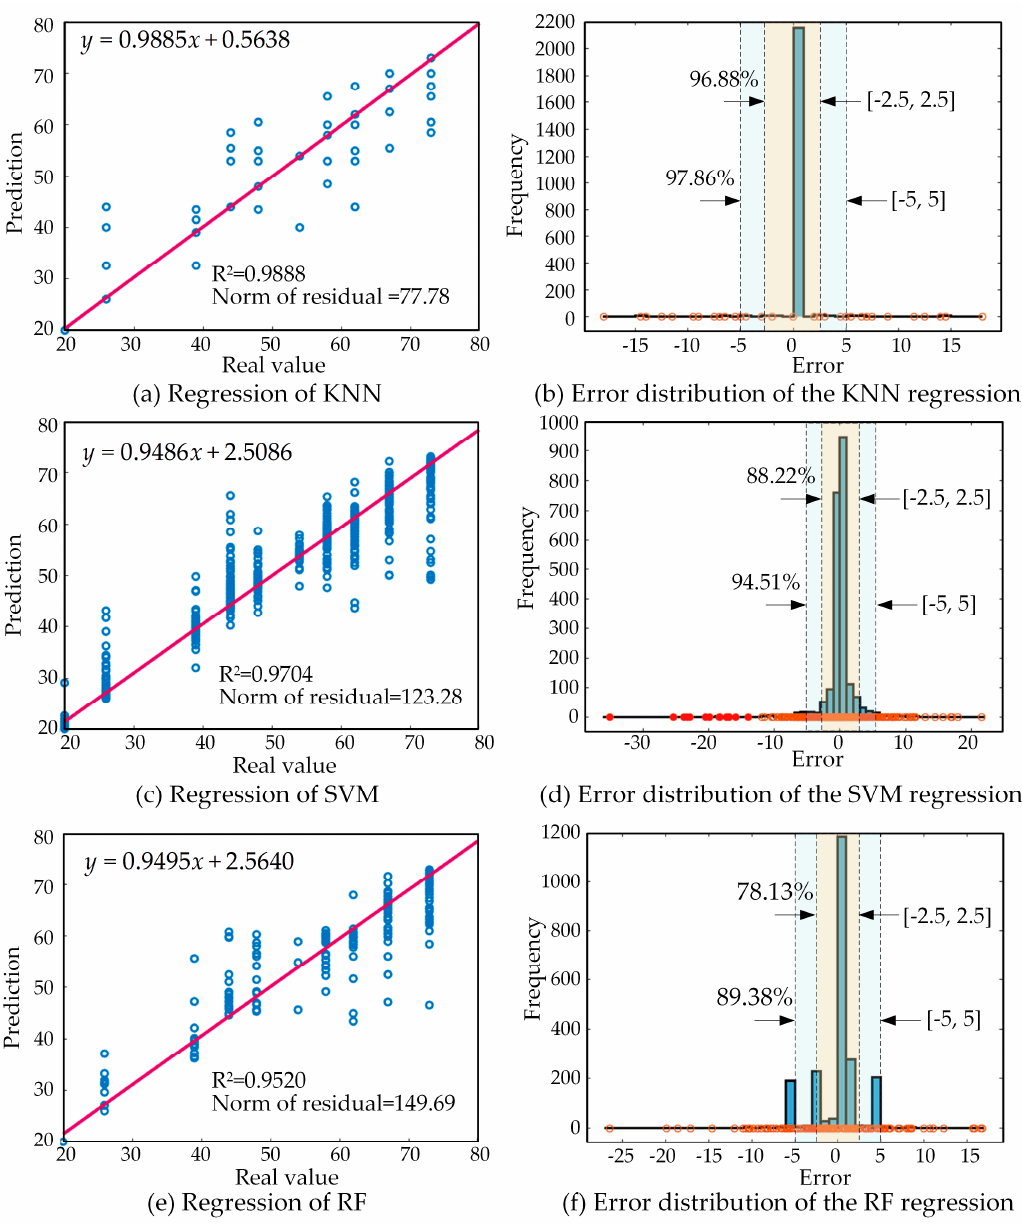
Figure 9. Predictions of Batch A.